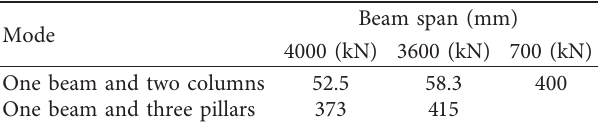
Figure 2: The advanced support simplified mechanical model. (a) One beam and two columns. (b) One beam and three columns. Table 4: The carrying capacity of π type steel beam in different